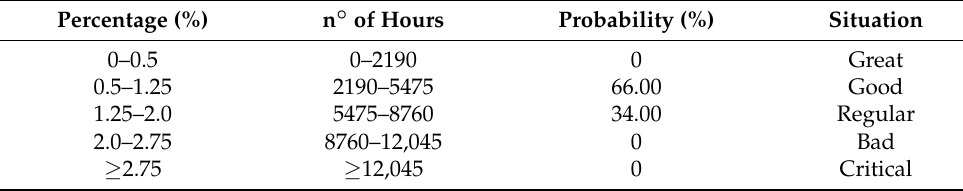
Table 3. Probability of Occurrence by HSS Interval—Simulation